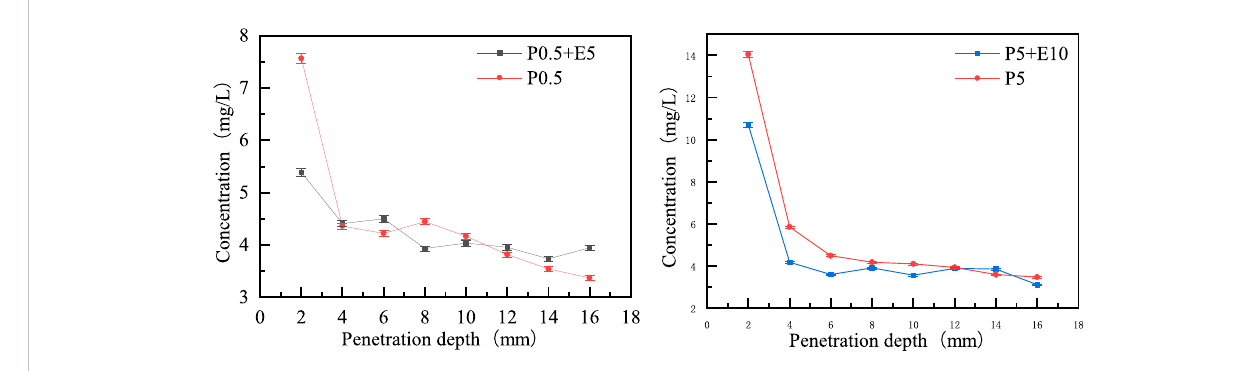
FIGURE 10 In fl uence of other ion chelators on chelated ion transport processes.